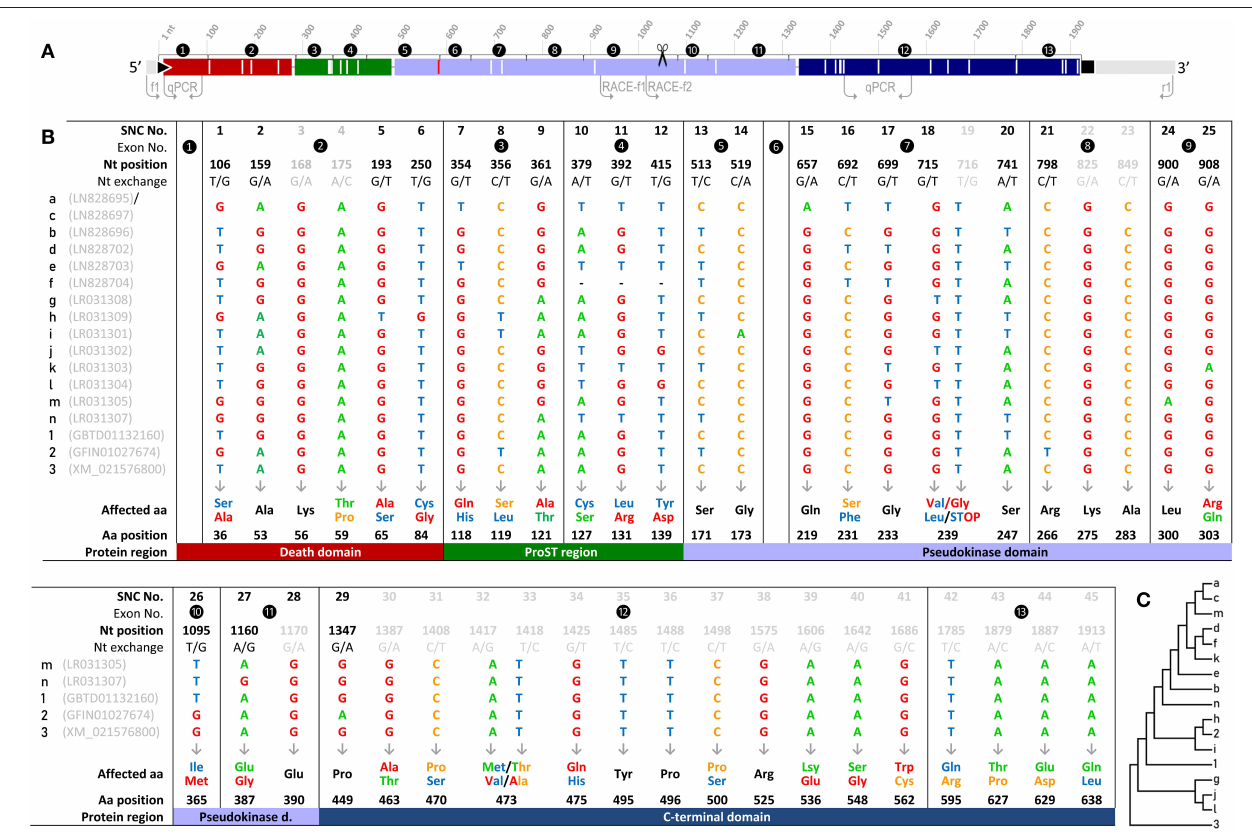
FIGURE 2 | (A) Schematic illustration of the irak3 -cDNA variants. The encoded protein domains are colored as in Figure 1 (upper panel) and drawn to scale. Flanking light gray lines indicate UTR sequences; the black triangle and square mark the start and stop of the ORF, respectively. Non-synonymous SNCs are represented by longitudinal white lines; the longitudinal red line indicates the point mutation that leads to the shortened variant j . Arrows indicate the locations of the primers used for fragment amplification and the 3 ′ -RACE. The scissors symbol indicates the end of the truncated irak3 -cDNAs. (B) List display of the 45 SNCs in trout Irak3-encoding cDNA sequences predicted by RNA-sequencing and those confirmed via cloning. The SNCs are numbered in the first row together with their exon-related occurrences and the exact positions in the ORF, with “1” assigned to the first nucleotide of the translational start triplet. Twenty-three of the SNCs were also confirmed by sequencing 100 randomly picked clones from batch-cloned irak3 amplicons. SNCs not represented in that clone collection are shown in gray characters. Nucleotide variations and the affected aa residues are marked with the same colors (adenine, green; guanine, red; thymine, blue; cytosine, orange). Characteristic domains carrying the affected aa residues are indicated by differently shaded table fields. Note that variants a and c share the same SNCs, but bear an additional nt exchange at position 407 (C) Dendrogram of trout irak3 cDNA variants. The bootstrap analysis of transcript relatedness involved 17 trout-specific nucleotide sequences (abbreviated as numbers and digits as indicated in (B) in the left column of the